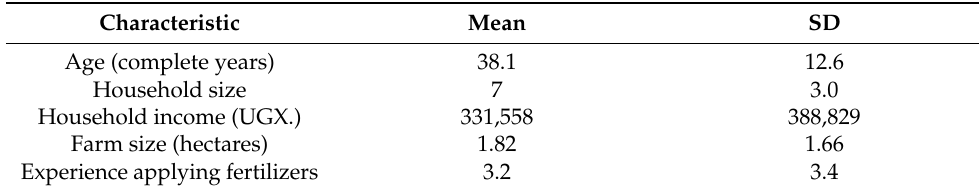
Figure 3. Percentage of farmers and their sociodemographic characteristics. Table 2. Farmers’ Socio-Demographic Characteristics.